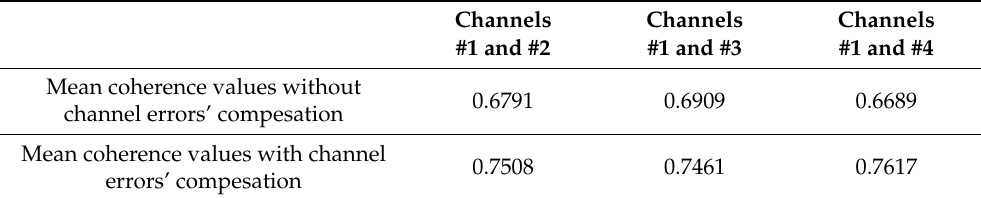
Table 5. Mean coherence values of different channel pairs.